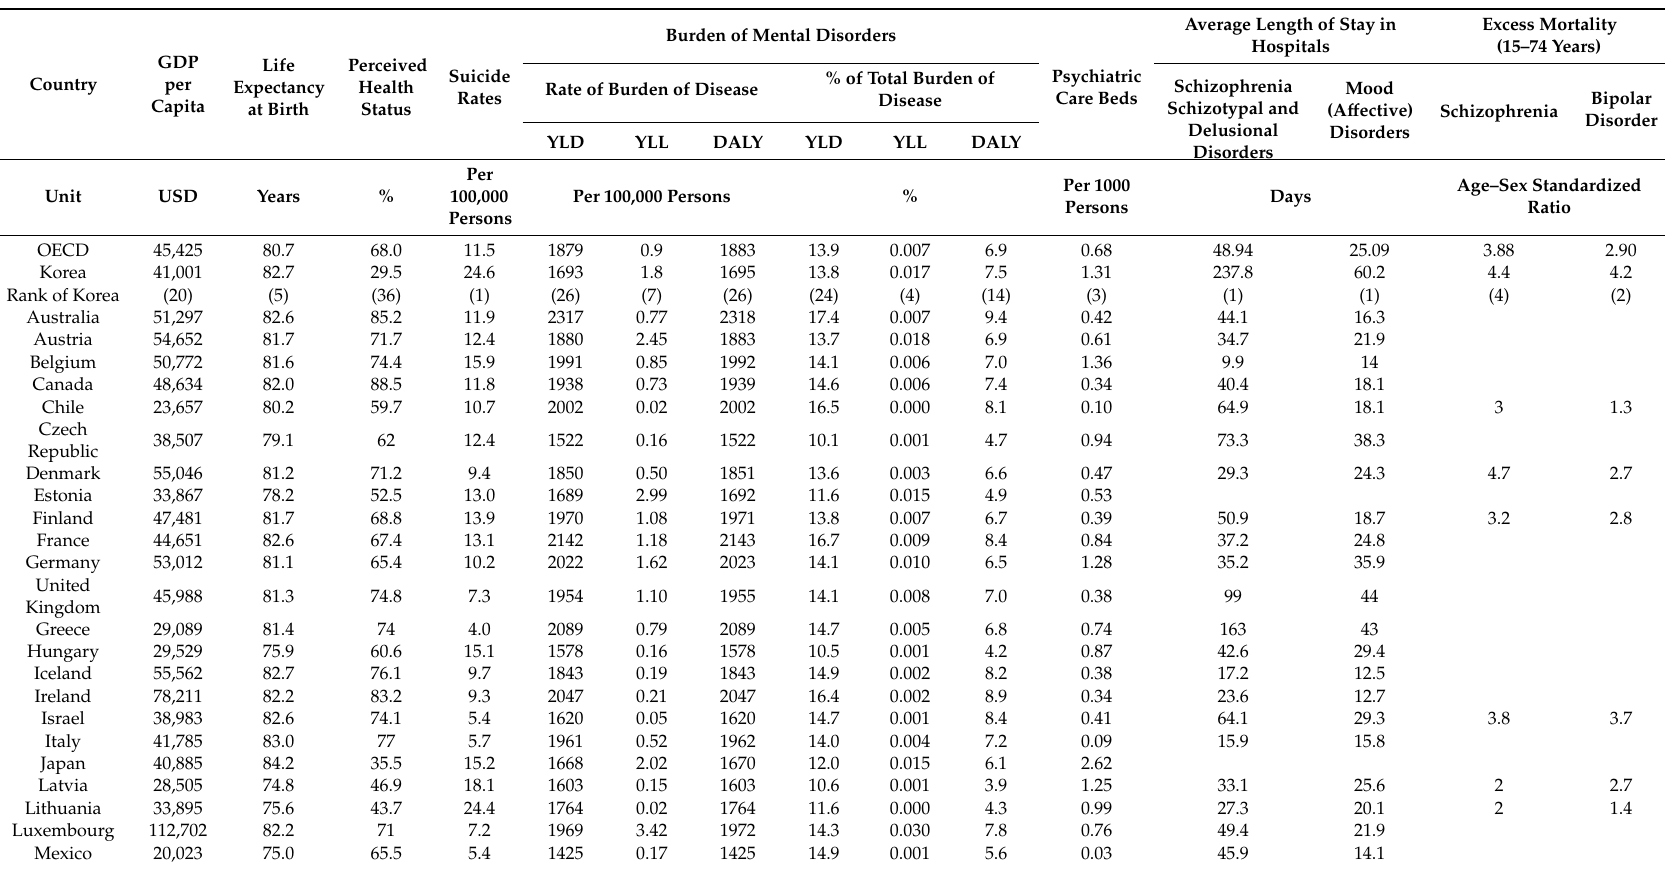
Table A1. A. Mental health related indicators for OECD